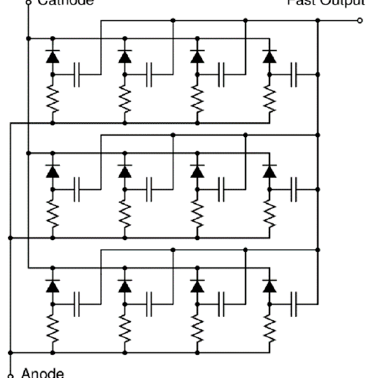
Figure 2. Simplified schematic of the SiPM from the supplier OnSemi, consisting of an array of SPADs and quenching resistors. Reprinted with permission from ref. [50]. Semiconductor Compo ‐ nents Industries, LLC., dba onsemi 2022.